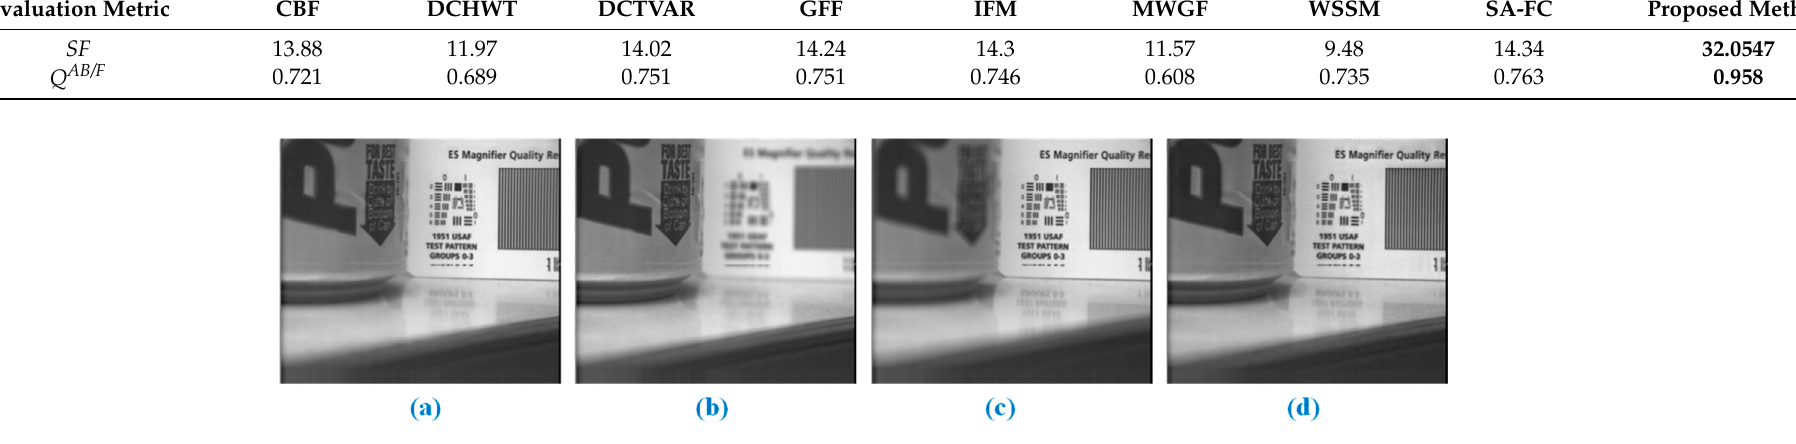
Figure 15. (Pepsi): ( a ) original image; ( b , c ) multi-focus input images; and ( d ) proposed Table 33. The outcomes for the Pepsi image and comparisons with existing techniques in the litera- ture ([24]).